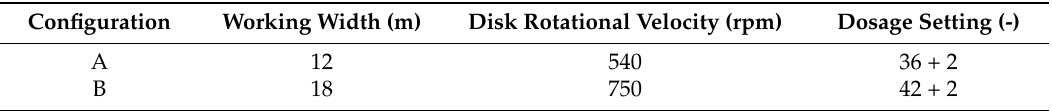
Table 2. List of settings used in this study for the Vicon RO-XL (VN236) spreader. In all cases, the spreader was placed horizontally with disks 750 mm above ground. The position of the orifice was set at N and a dosage of 116 kg/ha was used.